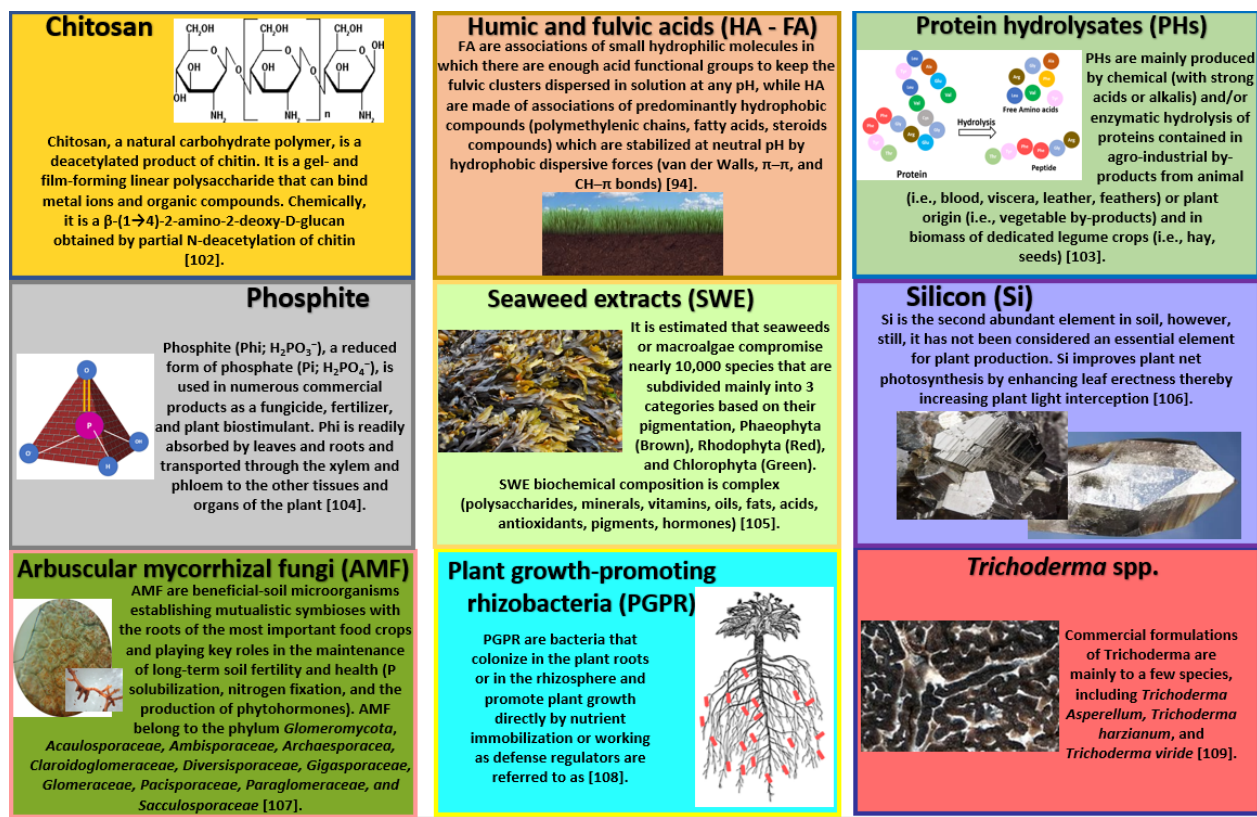
Figure 2. Categories of plant biostimulants [94,102–109].